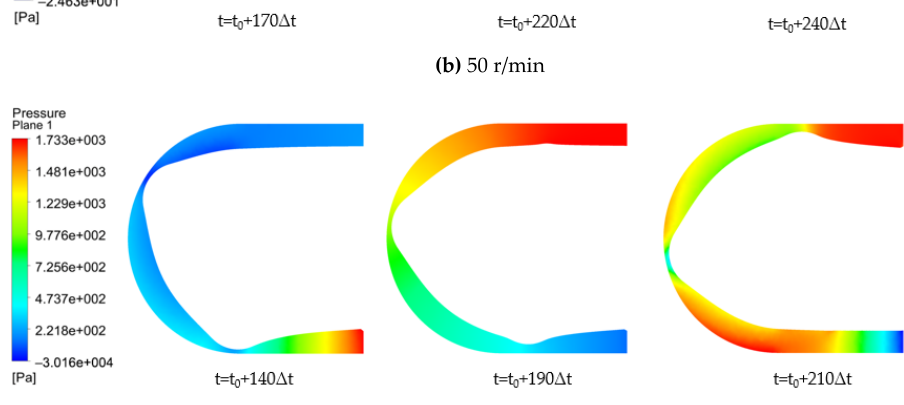
Figure 9. Static pressure distribution of the 0 MPa outlet pressure at different speeds.